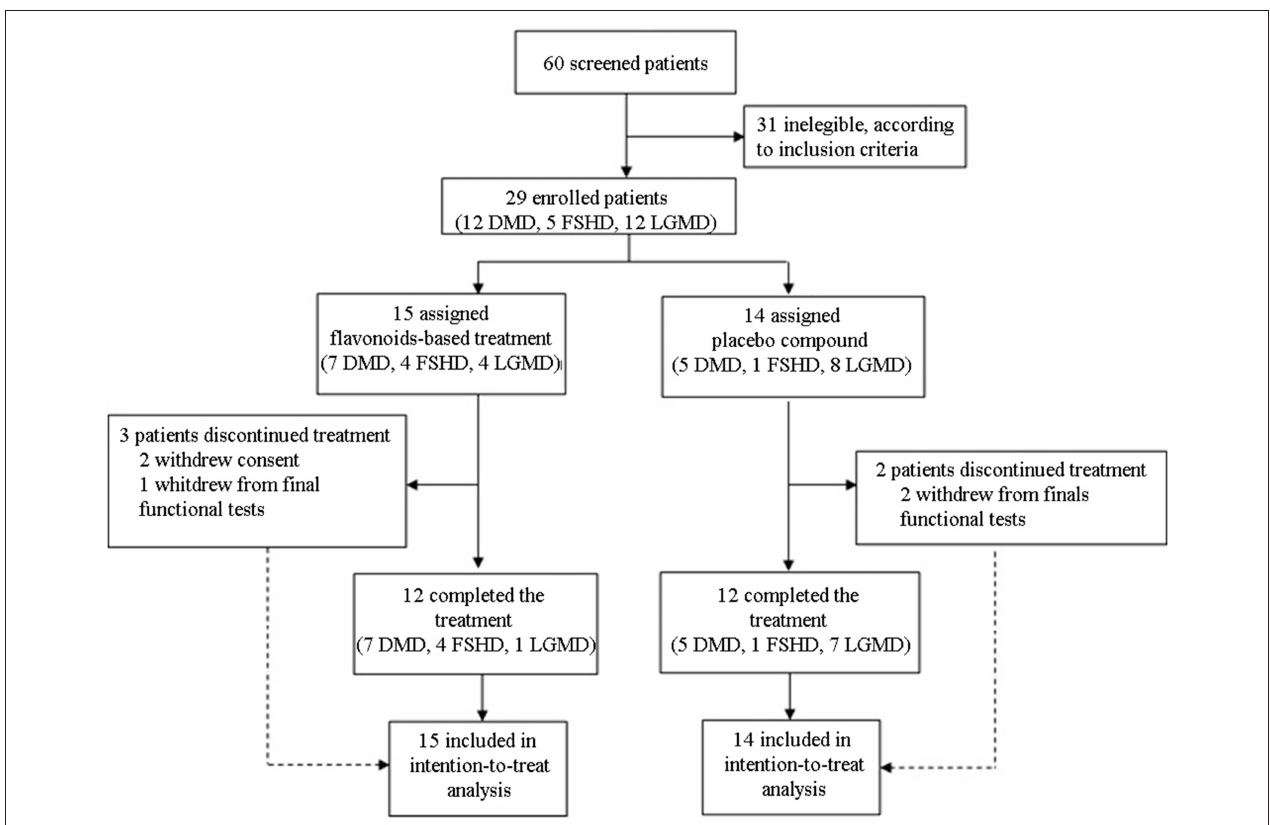
FIGURE 1 | CONSORT flow